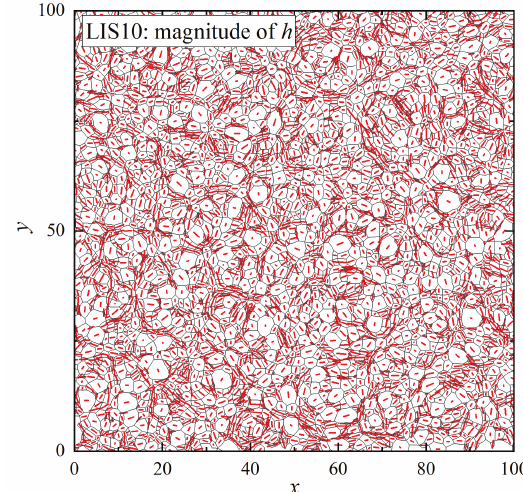
Fig. 11. Example of co-axiality between cell structure shown in black and the cell stress ratio in red lines (Longer line represents larger